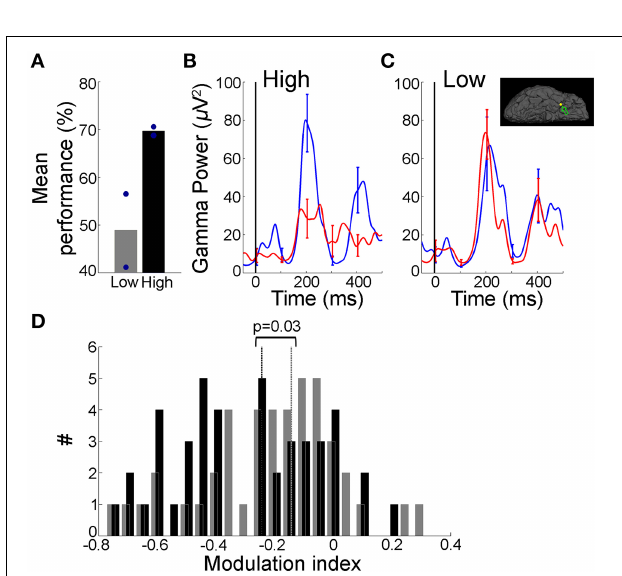
FIGURE 5 | Decrease in gamma band activity was restricted to learned sequences. (A) Performance across different sequences within a single level for an example subject that participated in Task 2. This subject learned five, eight-image long sequences during the course of this level. Behavioral performance for each sequence was calculated separately and sequences were ranked by performance (“low”/”high” = two sequences with lowest/highest mean percentage correct; circles indicate individual sequences). (B,C) Mean gamma frequency band power averaged over the early (blue) and late (red) trials (each 15 trials), for “High” sequences (B) and “Low” sequences (C) for an electrode in the right temporal pole (Talairach coordinates: 28.6, 3.7, − 37.0; inset in (C) depicts electrode position). Figure format is the same as Figure 2C . The gamma frequency band amplitude was significantly different between early and late trials in (C) ( p = 0 . 02, rank sum test, MI = − 0 . 11) but not in (C) ( p = 0 . 38, rank sum test, MI = 0 . 003). (D) Distribution of Modulation index values for sequences showing “High” (black) and “Low” (gray) behavioral performance across four subjects that successfully learned Task 2 and with ≥ 30 trials in the “High”/“Low” categories (dotted lines indicate median values). There was a significant difference in the MI values ( p = 0 . 03, rank sum test). The mean performance was 88 ± 10% for “High” and 58 ± 16% for “Low” sequences. Data from 22/31 electrodes that showed significant differences between early and late trials in Task